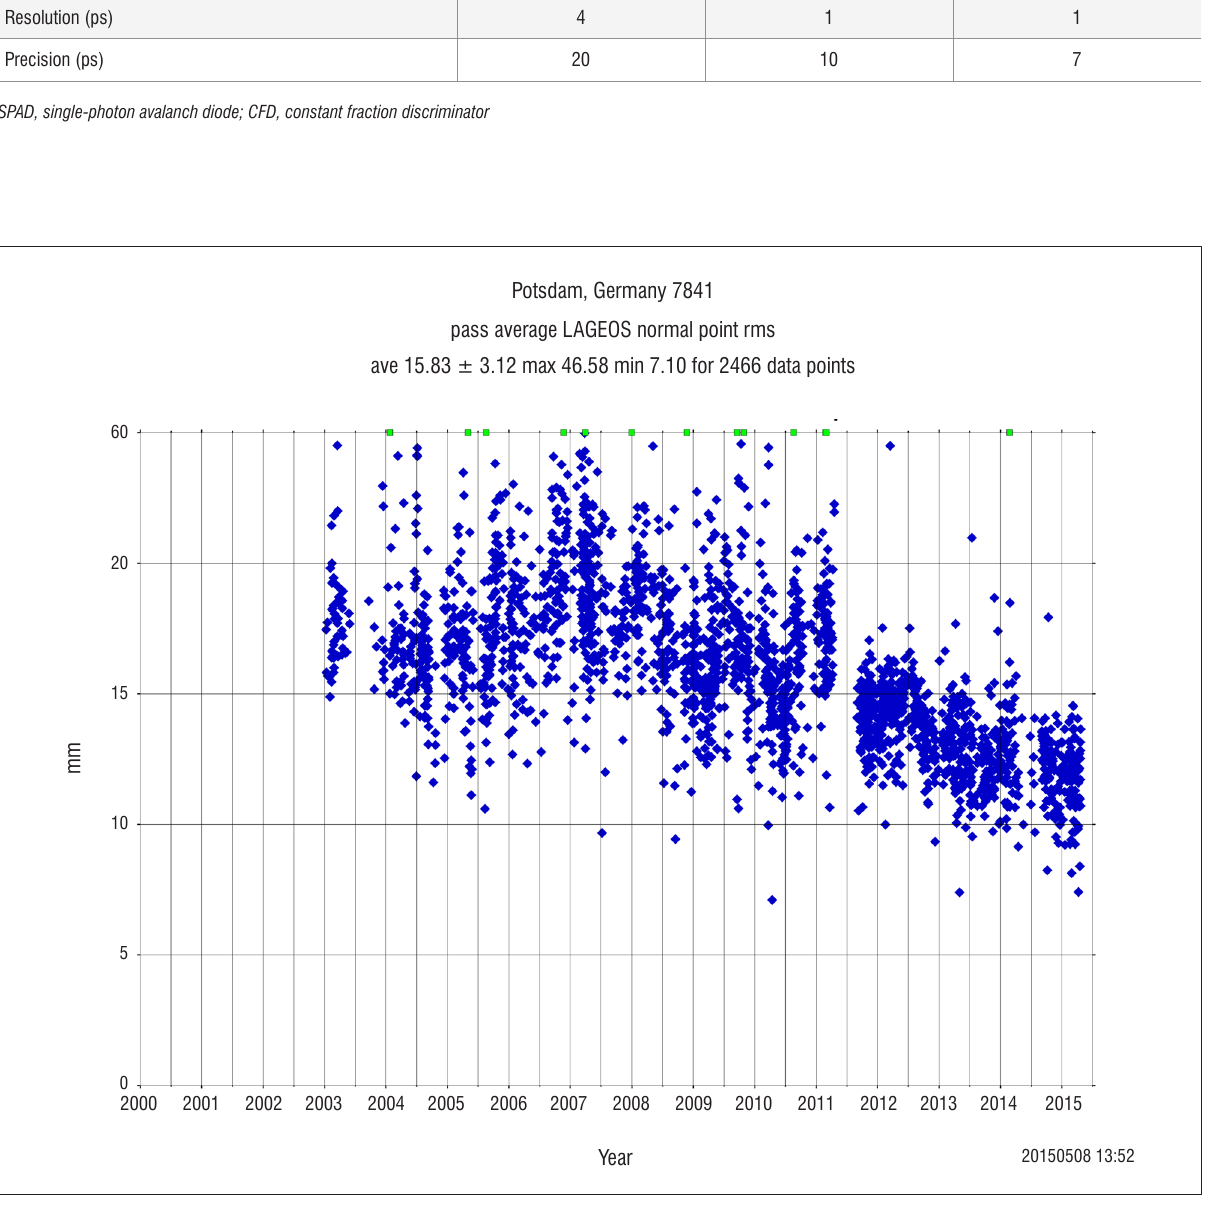
Figure 6: Potsdam satellite laser ranging station performance, measured based on normal point root mean square for LAGEOS ranging data. The single-photon avalanche diode was replaced with one of higher specifications in 2011.